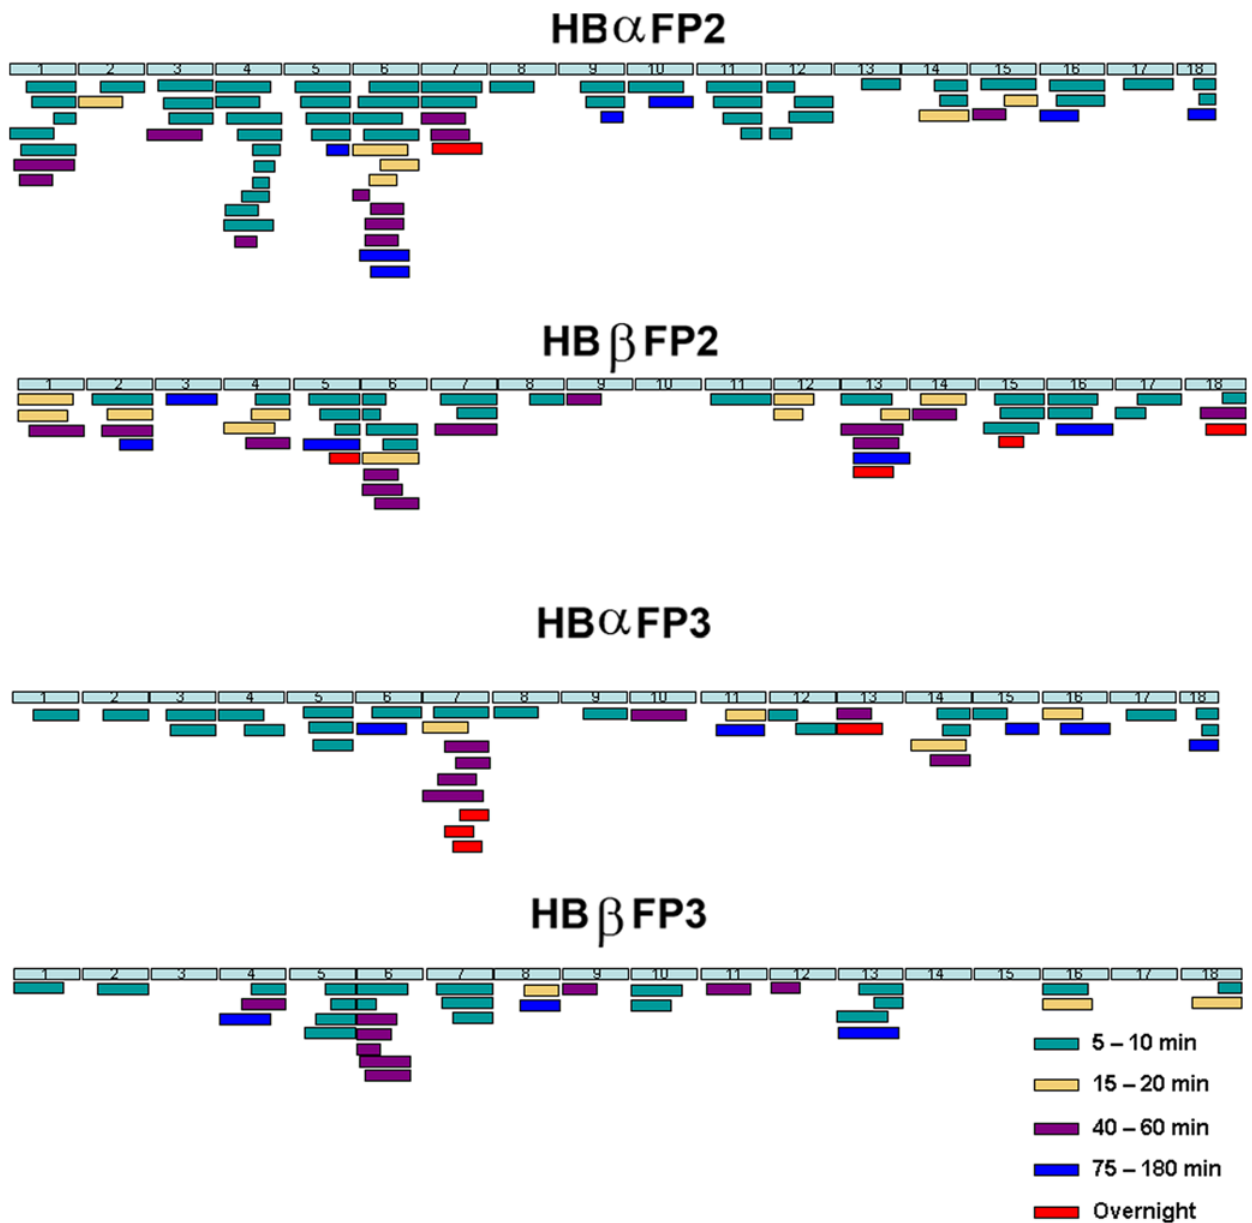
Figure 3. Time course for cleavage of globin peptides. Schematic representation of cleavage fragments over the indicated time points based on analysis of cleavage of 12-mer peptides spanning the sequences of a and b globin.